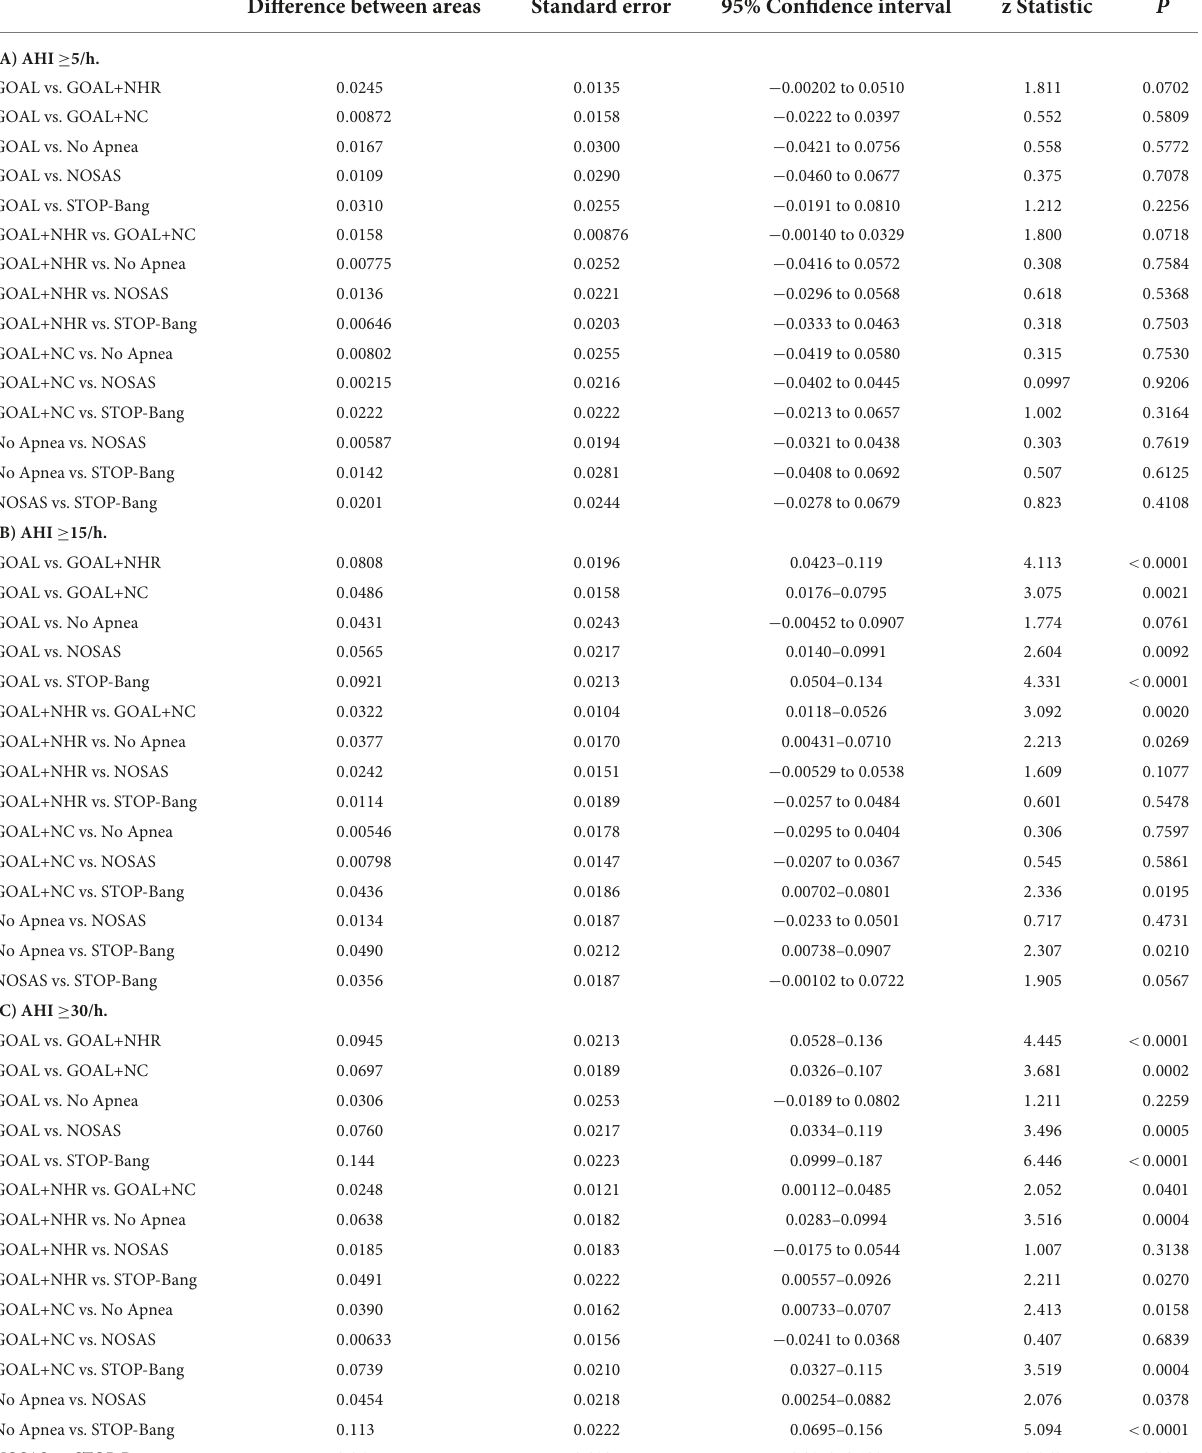
TABLE A1 Pairwise comparison of ROC